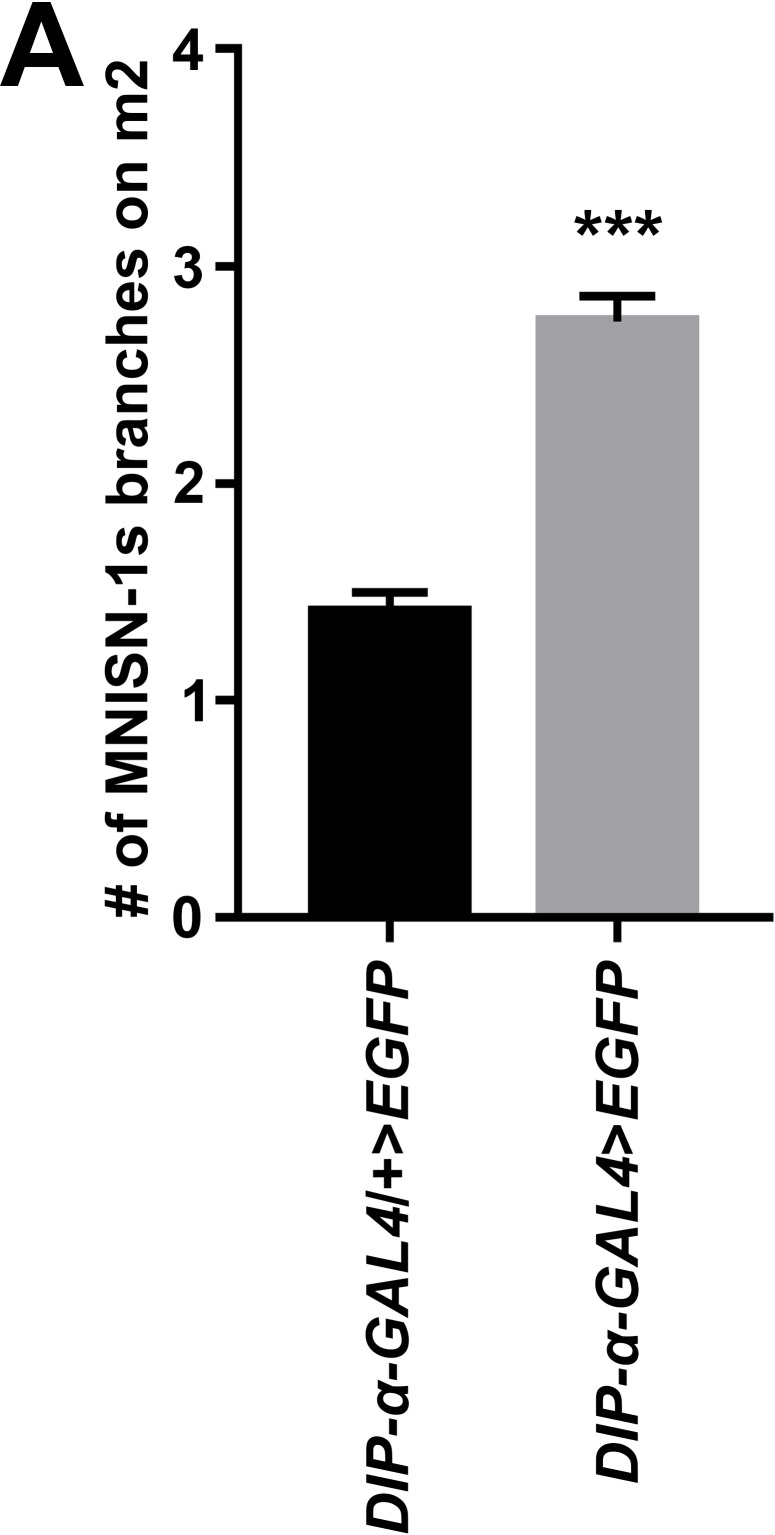
Quantification of MNISN-1s arbor branches on m2.(A) Quantification of the number of MNISN-1s branches on m2 in controls (DIP-α-T2A-GAL4/+) and hemizygous nulls (DIP-α-T2A-GAL4/Y). n (animals/hemisegments) = (13/54), (15/59) (respectively). Error bars represent SEM. ***p<0.0001. See also Figure 4.